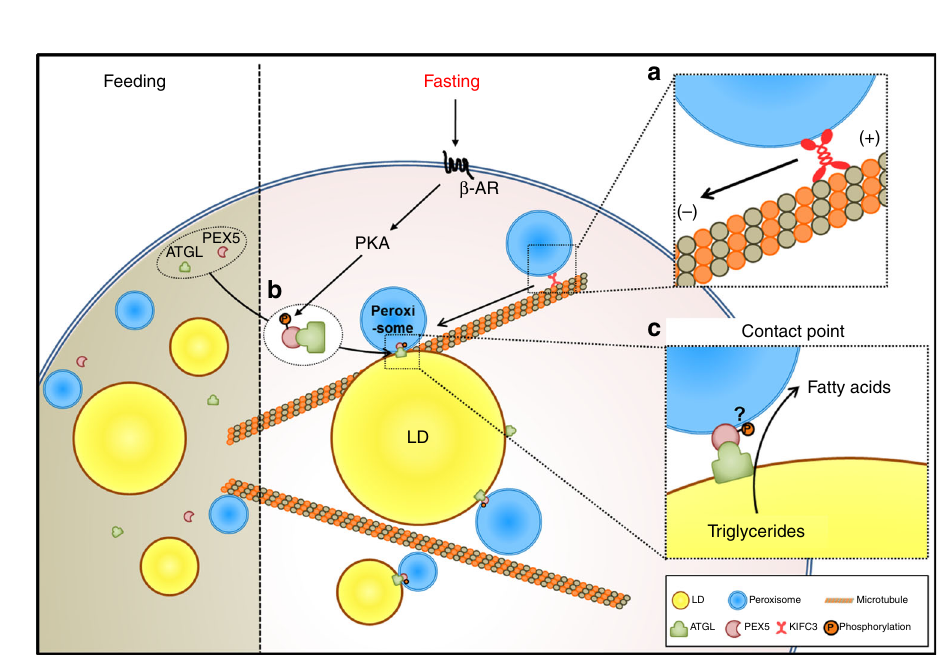
Fig. 8 Working model. During fasting, peroxisomes move to LDs via microtubule and this movement is mediated by KIFC3 ( a ). PKA activation increases PEX5 phosphorylation and PEX5 interacts with ATGL independent of canonical PTS1 ( b ). Then, PEX5 – ATGL complex translocates to the contact points between PER – LD even though it needs to be further elucidated whether PEX5 phosphorylation is important for PEX5 – ATGL translocation to the contact points between PER – LD. Finally, fasting-induced lipolysis is elevated ( c